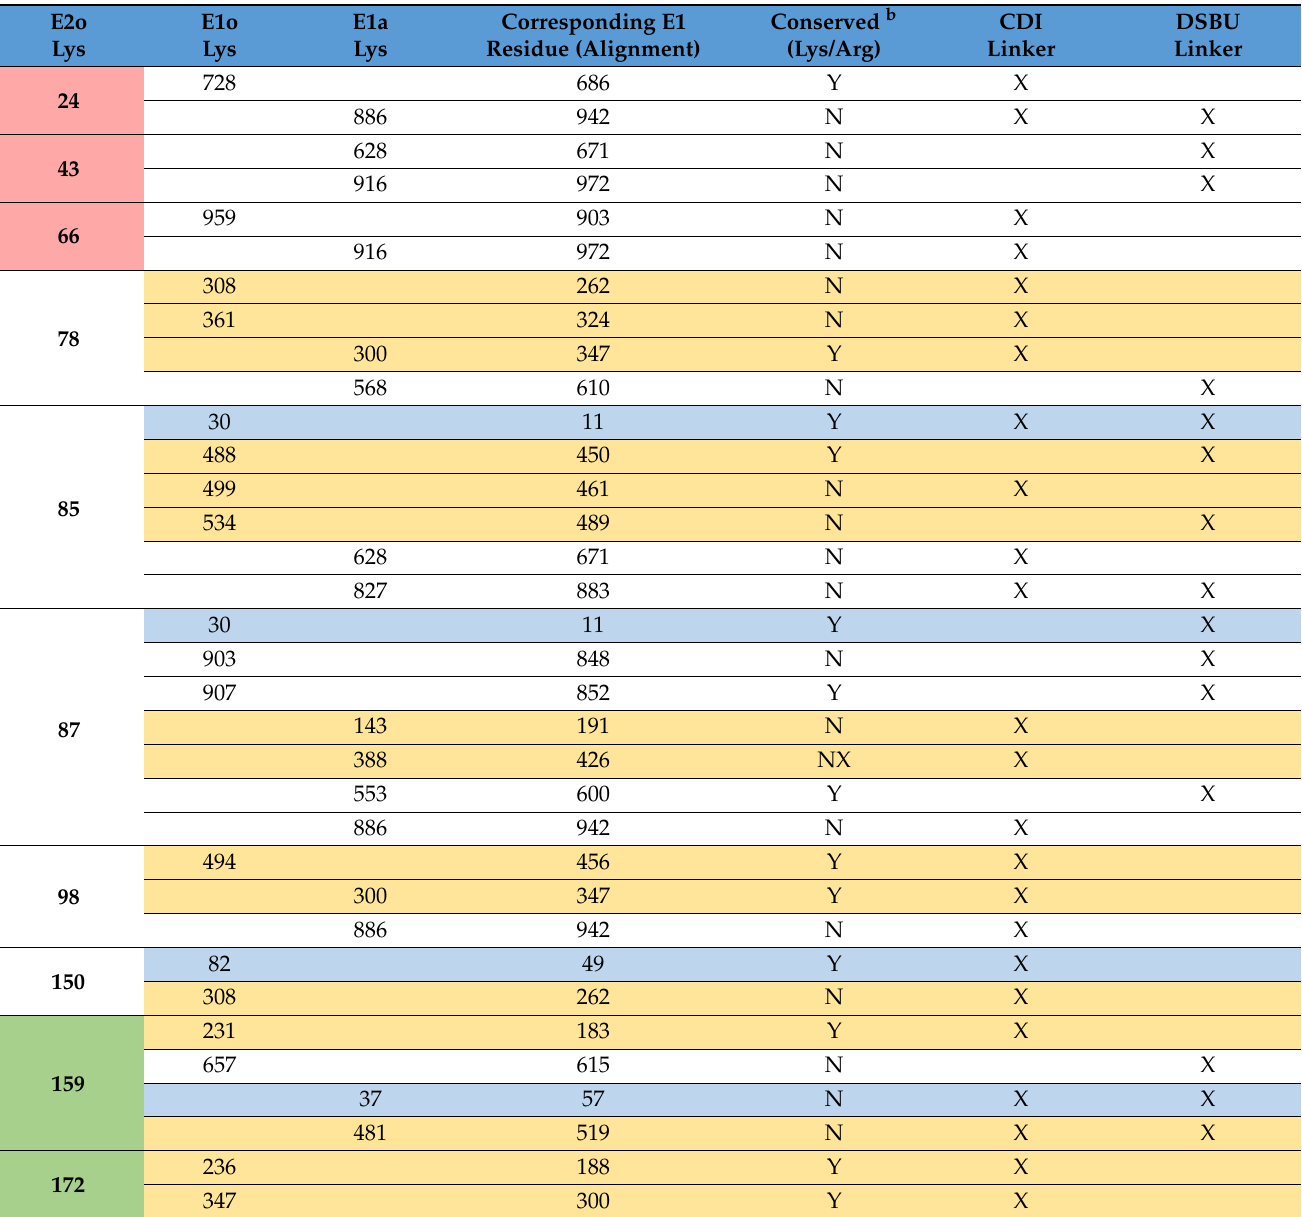
Table 1. Intersubunit cross-links, identified by CDI and DSBU, in the hE1o-hE2o and hE1a-hE2o binary subcomplexes a . The corresponding residue of the other E1 protein is specified. The numbering corresponds to that of the mature protein sequence. The hE1s and E2o domains are color-coded as follows: the hE1 N-terminal domains in blue , the hE1 α / β 1 domains in yellow , the hE2o lipoyl domain in pink , and the hE2o core domain in green